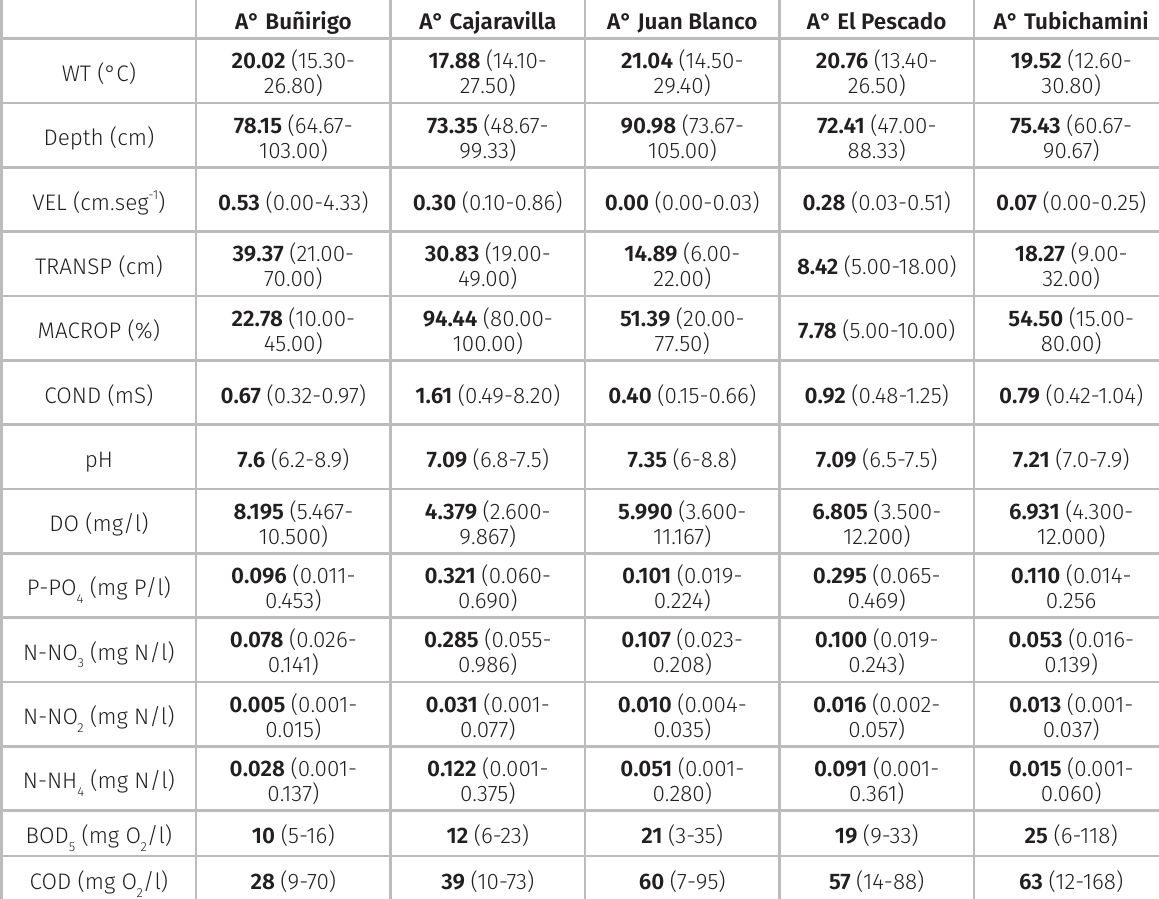
Table II. Mean values (min-max) of the physicochemical parameters recorded at the sampling sites.